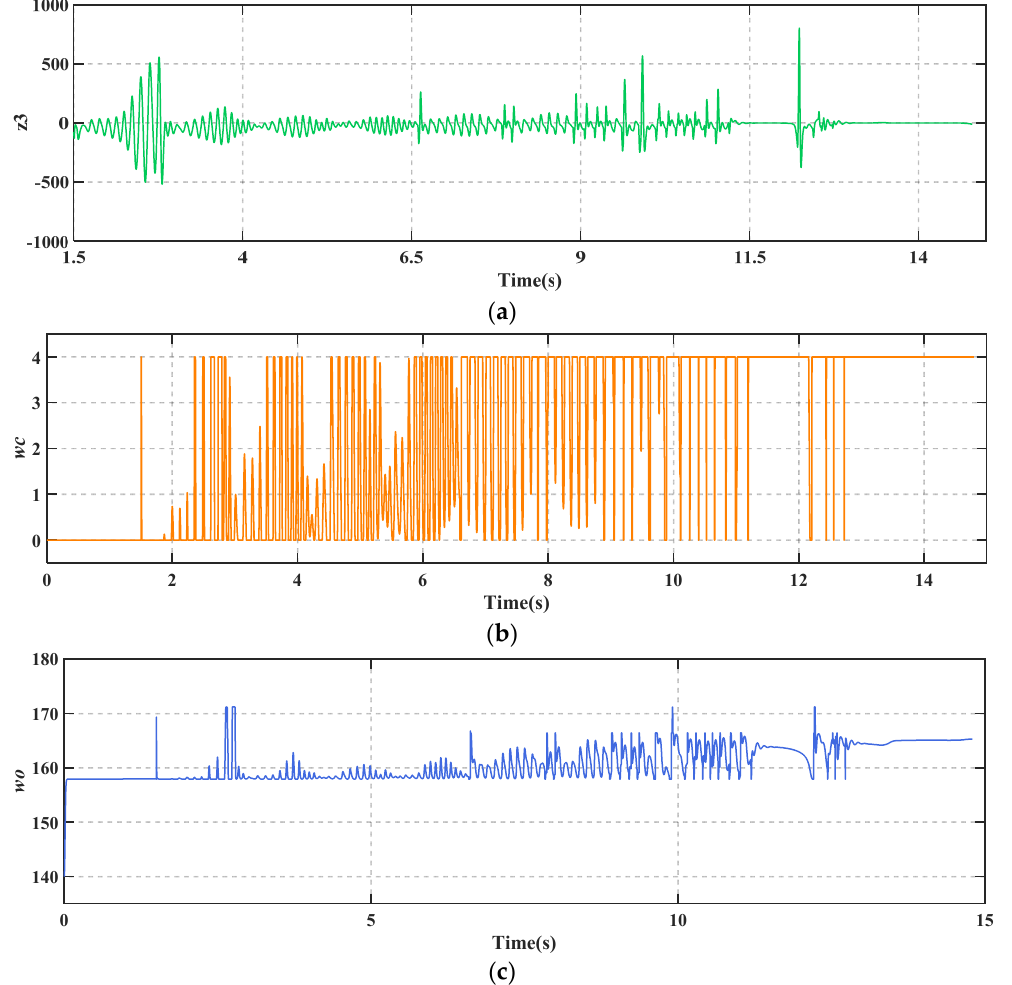
ω ; ( c ) observer bandwidth